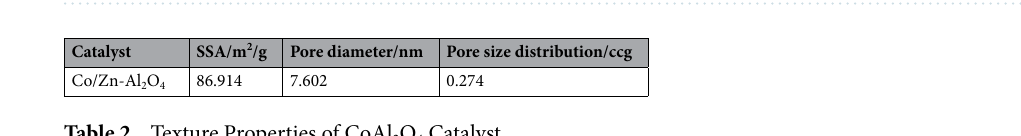
Table 2. Texture Properties of CoAl 2 O 4 Catalyst.